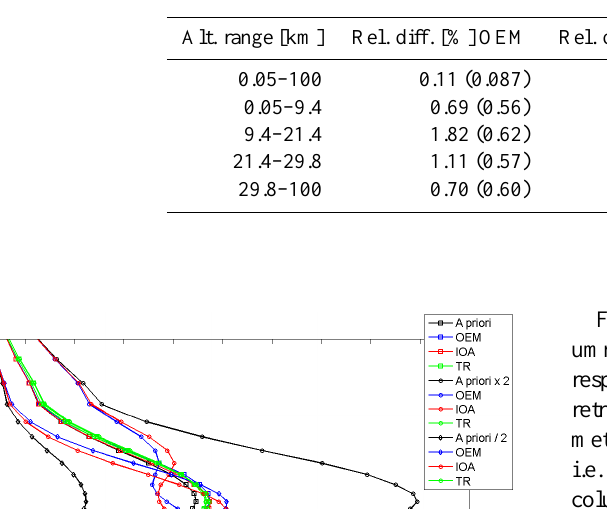
Table 8. Mean relative differences with corresponding standard deviations (between brackets) between retrieved and “input” total and partial columns of O 3 from simulated spectra.